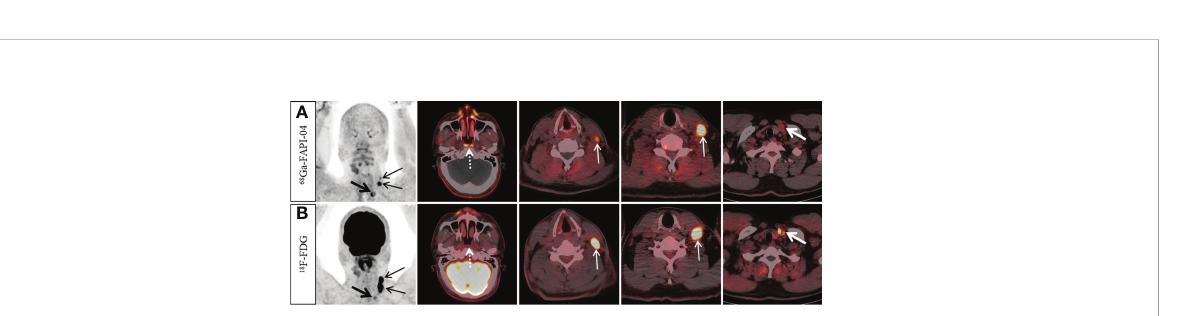
FIGURE 1 A 49-year-old man with nonkeratinizing differentiated carcinoma. 68 Ga-FAPI-04 PET/CT showed intensive 68 Ga-FAPI-04 uptake in the posterior nasopharyngeal wall ( A , dotted arrow, SUVmax 3.8), 18 F-FDG PET/CT showed no abnormal 18 F-FDG uptake in the primary tumor ( B , dotted arrow). Moreover, 68 Ga-FAPI-04 PET/CT reveals higher tracer uptake than 18 F-FDG PET/CT in the left supraclavicular lymph node ( A , thick arrow, SUVmax 9.4 vs. B , thick arrow, SUVmax 3.8), but the tracer uptake of left cervical (level III) lymph nodes was lower than that of 18 F-FDG PET/CT ( A , thin arrow, SUVmax, 4.5 – 11.0 vs. B , thin arrow, SUVmax, 17.7 – 19.4).